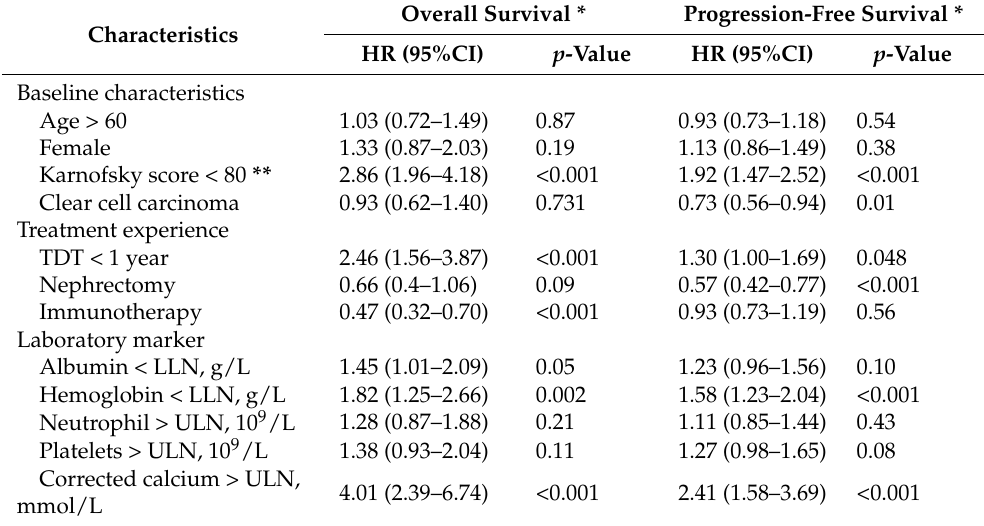
Table 2. Univariate analysis of baseline characteristics predictive for overall survival and progression- free